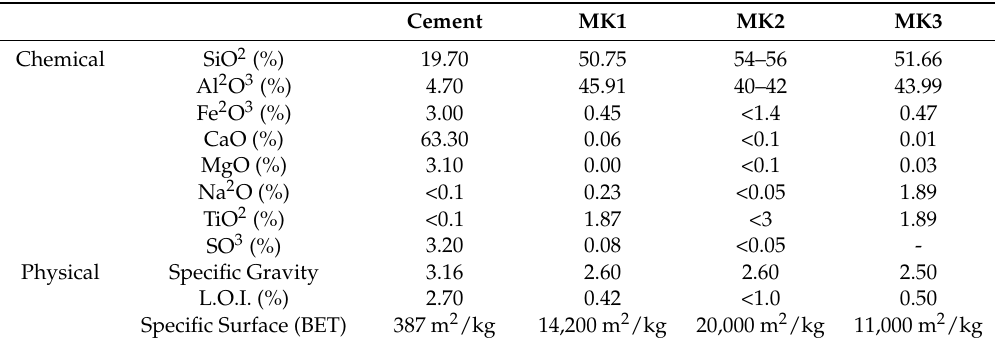
Table 2. Select physical and chemical properties of cementitious materials.